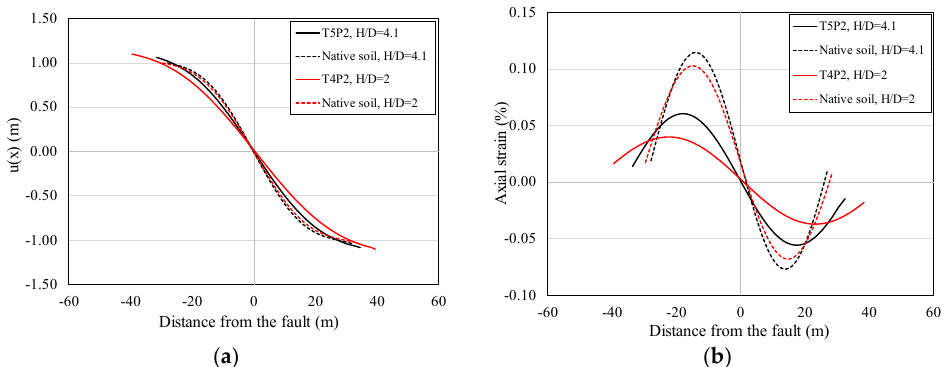
Figure 7. Comparison between the developed analytical model for the trenched pipeline and the analytical model for uniform seabed soil, T4P2 and T5P2 ( β = 0°): ( a ) deformed pipeline shape, ( b ) distribution of axial strains along the pipeline.